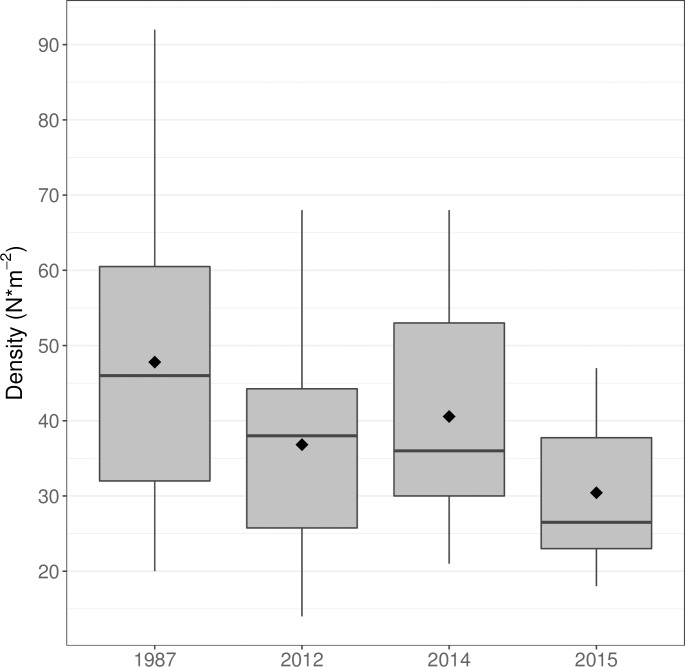
Temporal variation in average S. latissima density at Ammen Rock Site 1 during four sampling periods from 1987 to 2015.A significant 36.2% reduction of average kelp density occurred between 1987 and 2015 (S4 Table). The low kelp densities in 2012 occurred during anomalously warm sea surface temperatures (Fig 2, S1 and S2 Figs) when the kelp plants were extensively covered by the invasive bryozoan Membranipora membranacea (Fig 6E, S5 Table). The boxplots display the median value of the data as a horizontal bar, the first and third quartiles of the data (25th and 75th percentiles) as a shaded box around the mean, 1.5x the interquartile range (IQR) as a vertical line, and all outliers beyond +/- 1.5 IQR as individual dots. The diamond symbol represents the mean value.